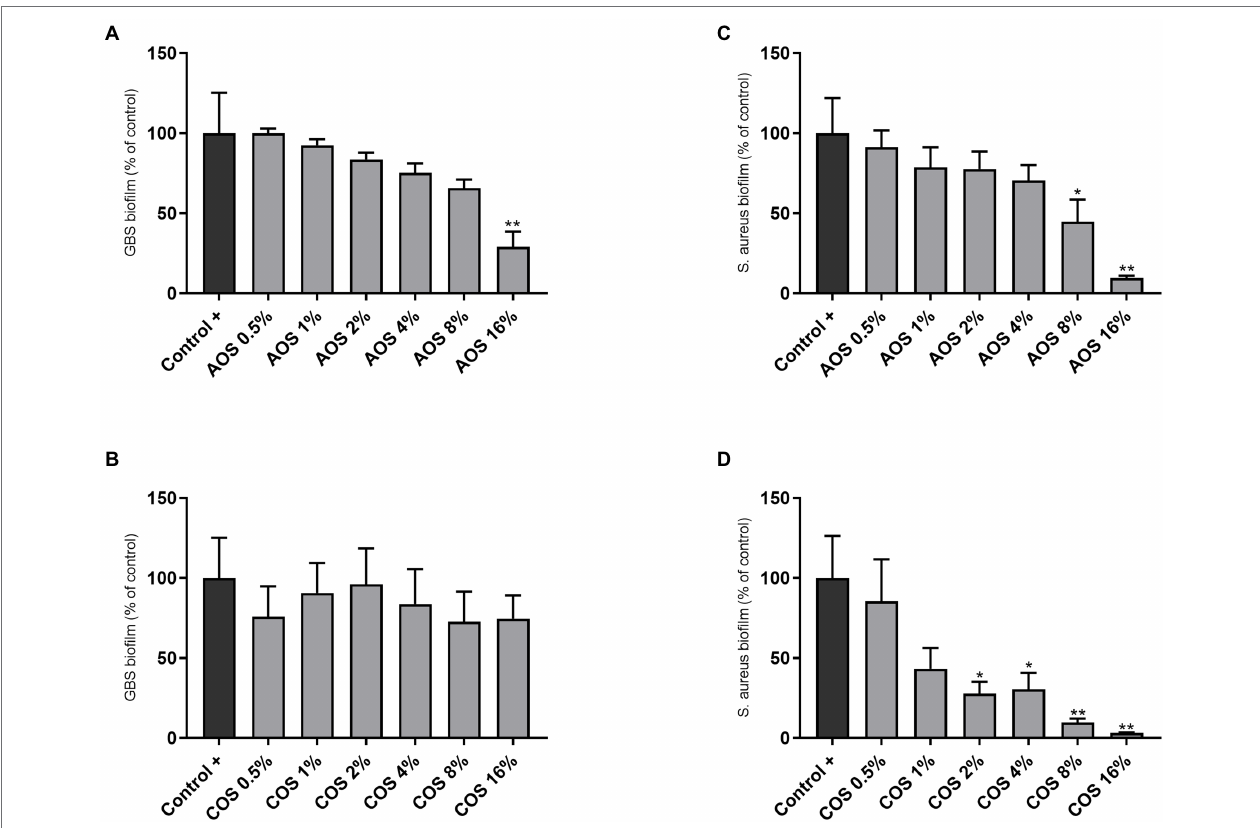
FIGURE 4 | Anti-biofilm activity of AOS and COS against GBS V and S. aureus wood 46 strains. For the biofilm formation assay, six 2-fold serial dilutions of AOS and COS were tested after 24 h of exposure, targeting the MBIC against GBS V (A,B) and S. aureus wood 46 (C,D) , as described in the Material and Methods section. Control ( − ) represents the negative control (uninoculated culture media without NDO treatment) and control (+) represents full-formed biofilms without any additional treatment 16% AOS and 8% COS are considered as MBIC against S. aureus wood 46. Results are expressed as the percentage of biofilm formation (relative to positive control) as mean ± SEM of three independent experiments each performed in triplicate. Statistical differences *( p < 0.05) and **( p < 0.01) compared to positive control were obtained using one-way ANOVA test. AOS, alginate oligosaccharides and COS, chitosan oligosaccharides.